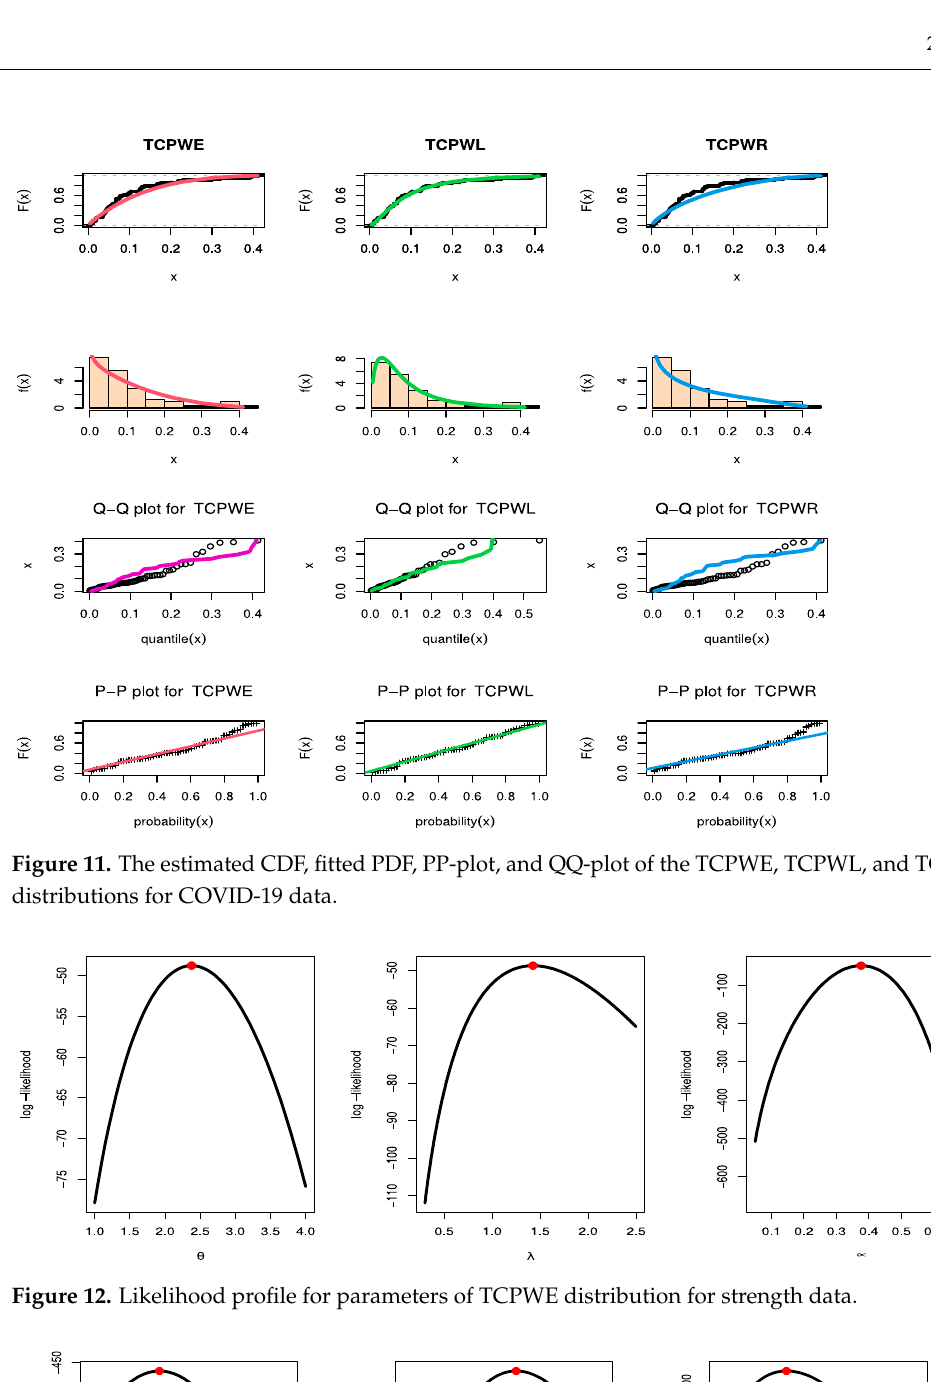
Figure 10. The estimated CDF, fitted PDF, PP-plot, and QQ-plot of the TCPWE and TCPWL and TCPWR distributions for fatigue times.